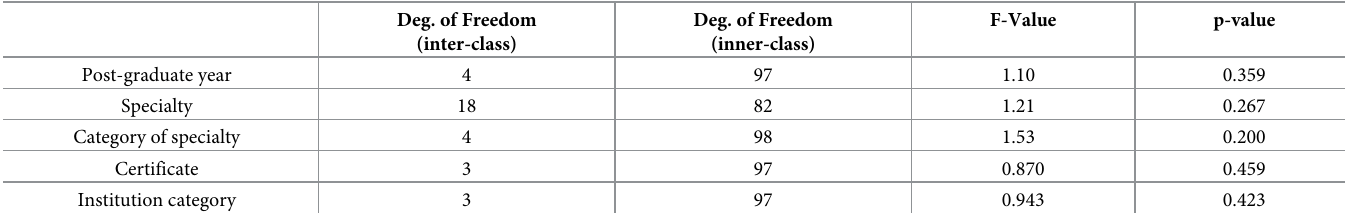
Fig 8. Known ratio, grouped by institution type: The error bars shows the standard errors. https://doi.org/10.1371/journal.pone.0209551.g008 Table 7. Result of one-way ANOVA for each